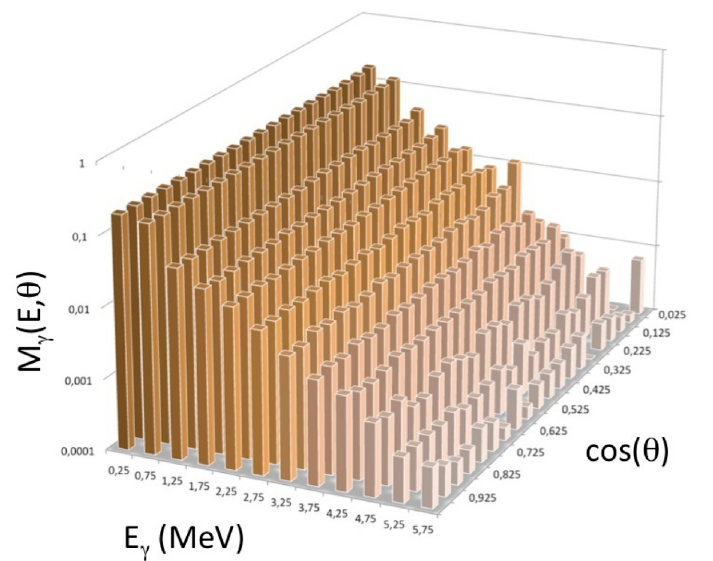
Figure 3. Three-dimensional presentation of measured PFGS from 252 Cf(sf) for angular bins of ∆ cos θ = 0.05 and energy bins of ∆ E = 500